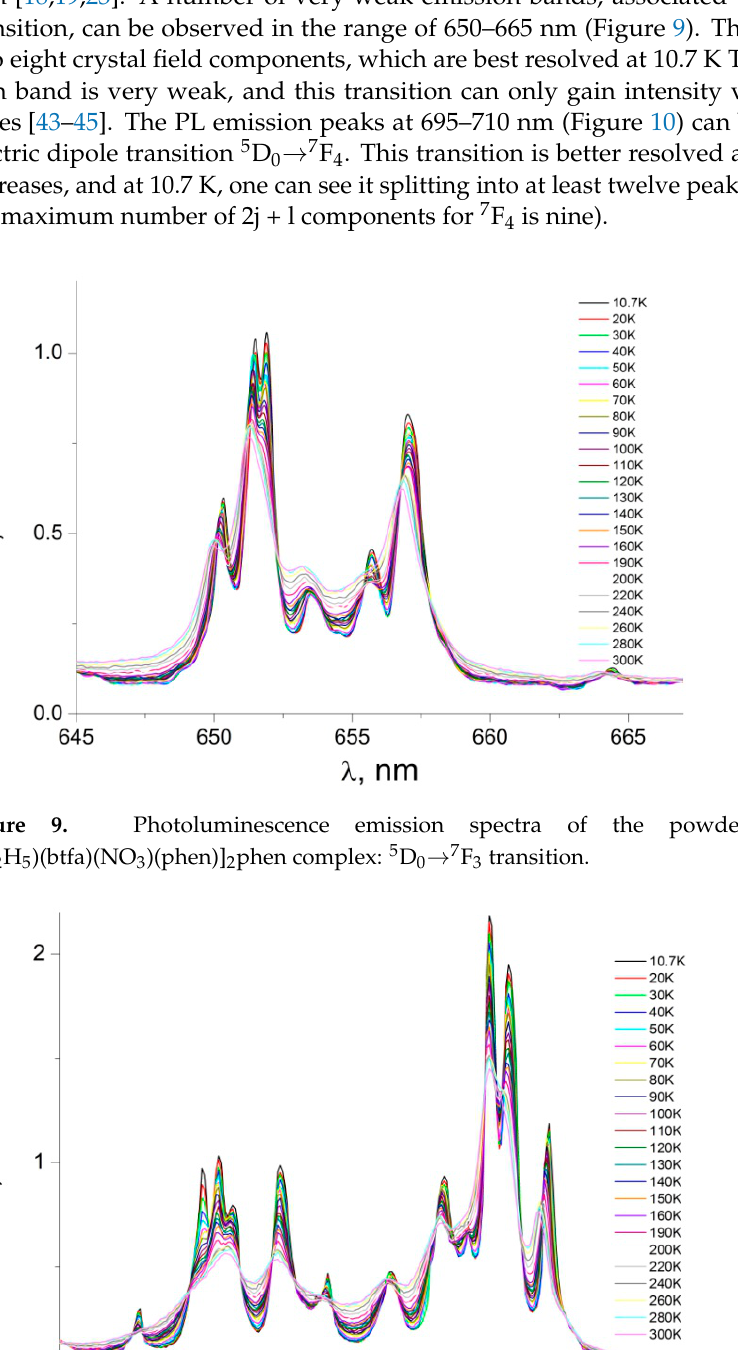
Figure 10. Photoluminescence emission spectra of the powder sample [Eu(µ 2 - OC 2 H 5 )(btfa)(NO 3 )(phen)] 2 phen complex: 5 D 0 → 7 F 4 transition.